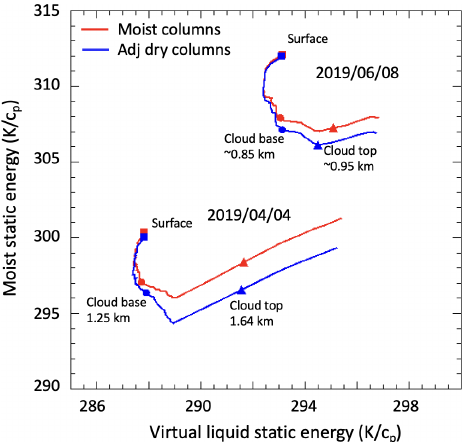
Figure 11. Average moist static energy versus virtual liquid static energy in moist and adjacent dry columns of the 2d shown in Fig. 9. Squares, circles, and triangles indicate surface, cloud base, and cloud